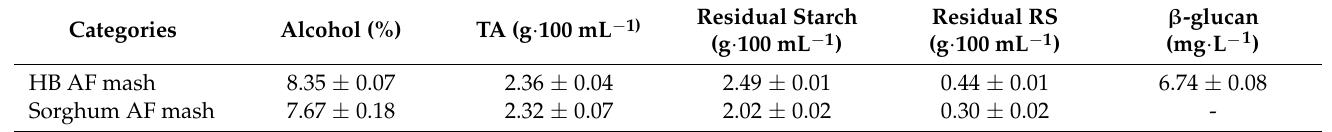
Table 2. The component contents in alcohol fermenting mashes of HB and sorghum.